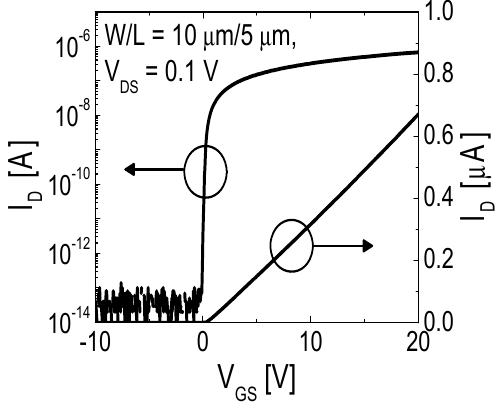
Figure 3. Transfer curve (logarithmic and linear scale) measured from the fabricated IGZO TFT at V DS = 0.1 V.